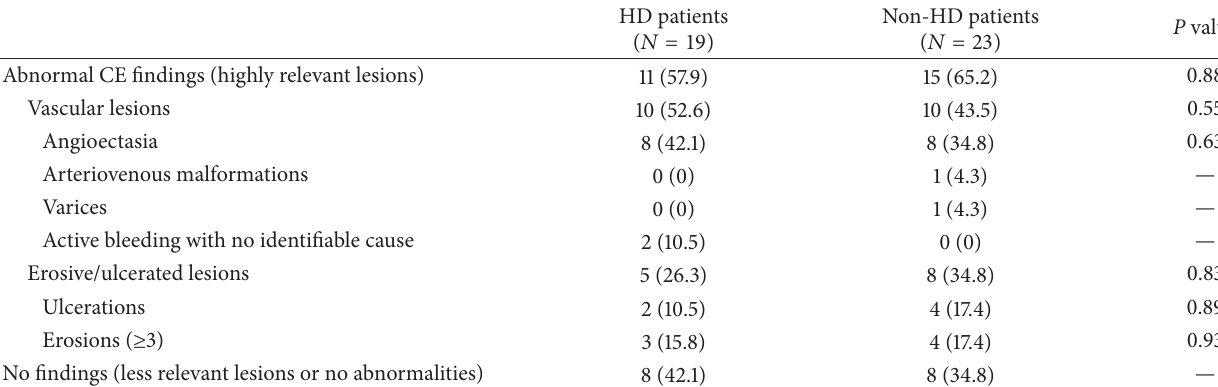
Table 3: Comparison of the CE findings between the HD and non-HD